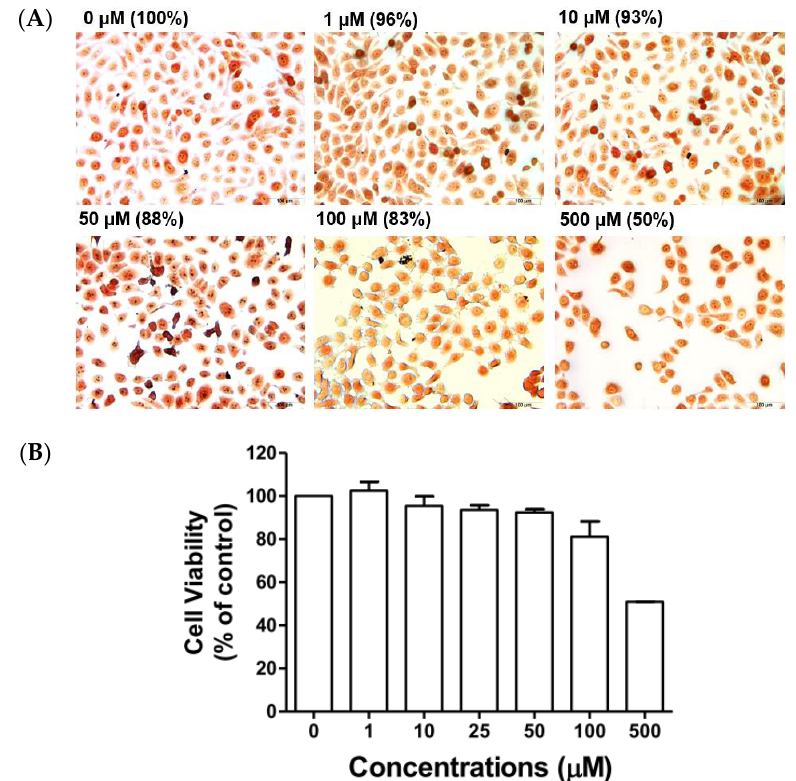
Figure 2. HaCaT cells were treated with 1 – 500 μM of 5c respectively and cell viability was assessed by Neutral Red assay. Data are presented as mean ± SD ( n =